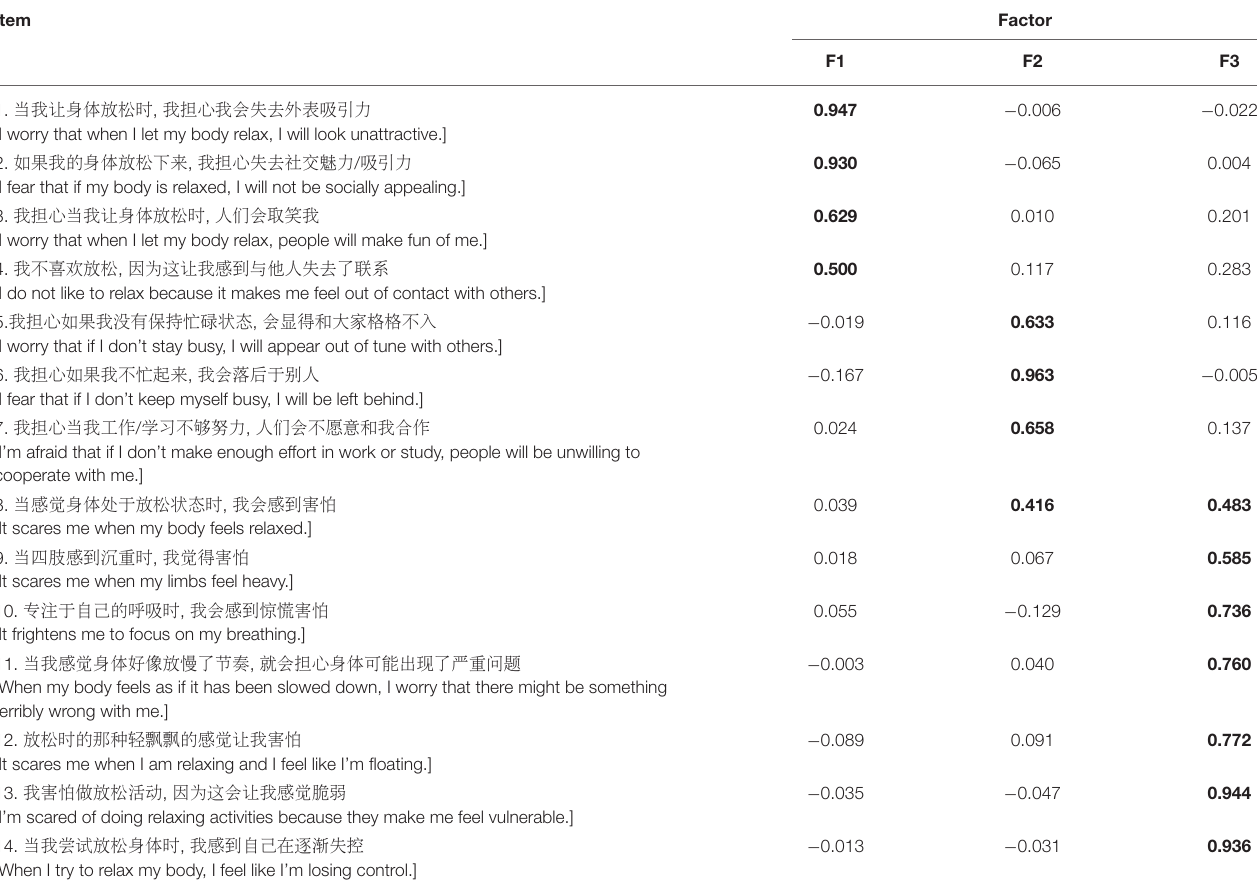
TABLE 2 | Factor loadings for the first three-factor model. Item